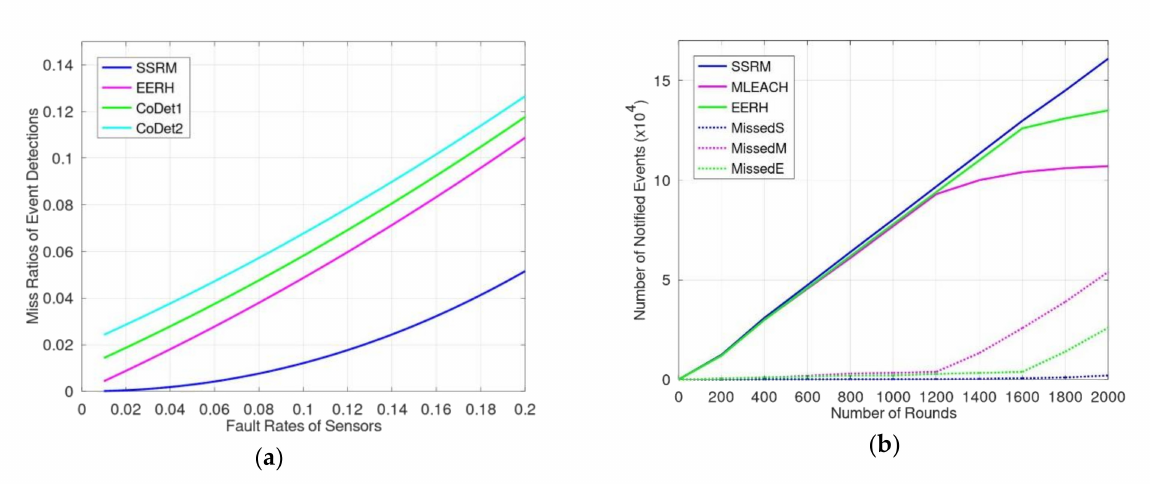
Figure 8. ( a ) The miss rates of event detection for mechanisms with di ff erent sensor fault rates; ( b ) monitoring performance of